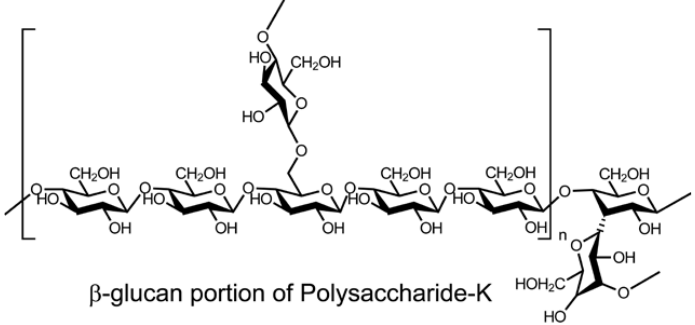
Figure 5. β -Glucan/protein complex isolated from Trametes versicolor (Turkey Tail mushroom) containing 25%– 38% protein. 94 kDa macromolecule. β -1 → 4-glucan backbone with 1 → 3/1 → 6 branching β -glucan. The protein consists of 28% acidic amino acids [7–9].